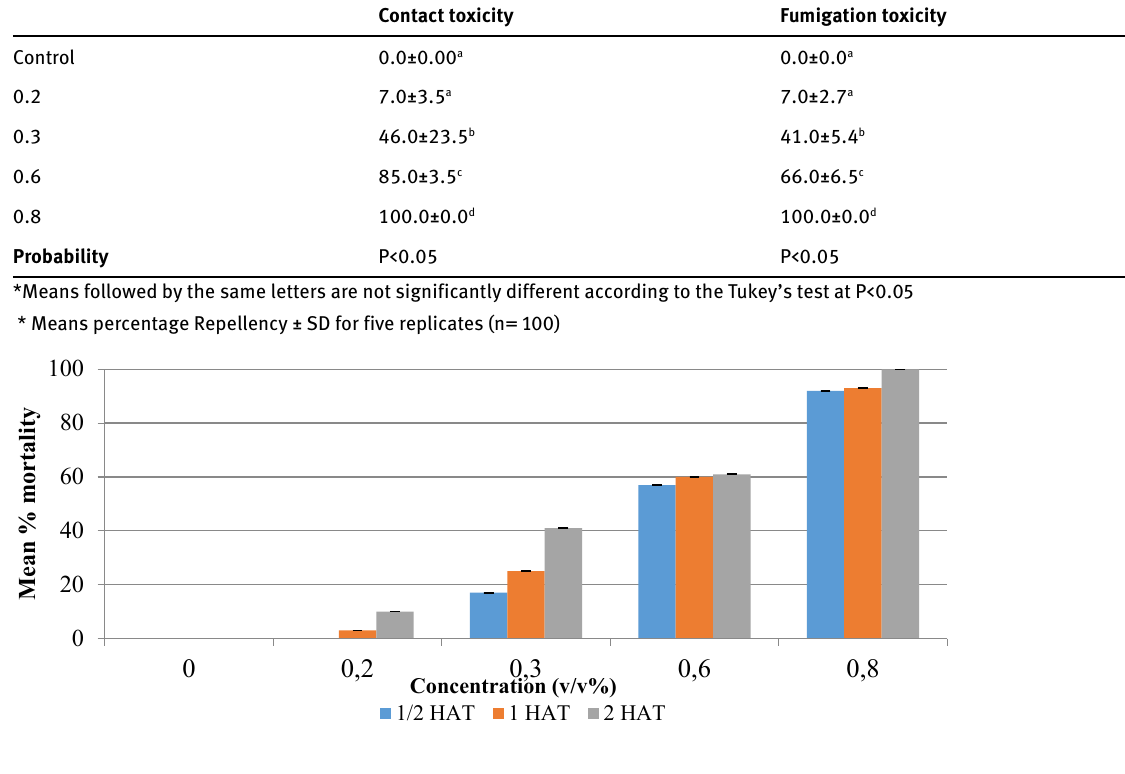
Table 2: Contact and fumigation toxic effect of P. dioica leaf essential oil on C. maculatus after 12 and 2 hours after exposure Concentration (v/v%)